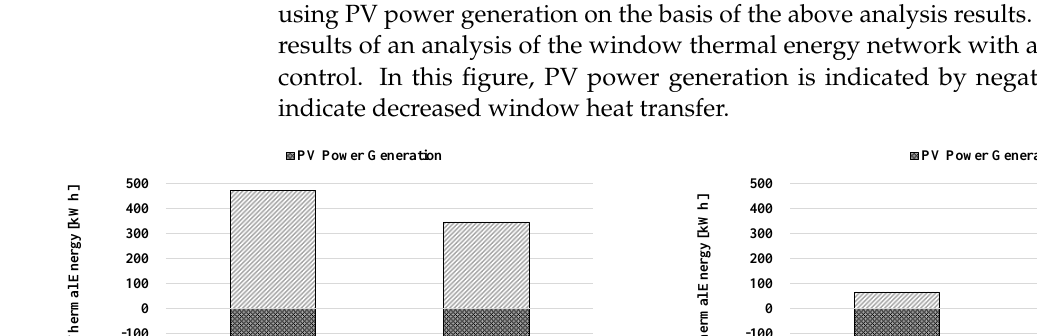
Figure 18. Variation in PV power generation.